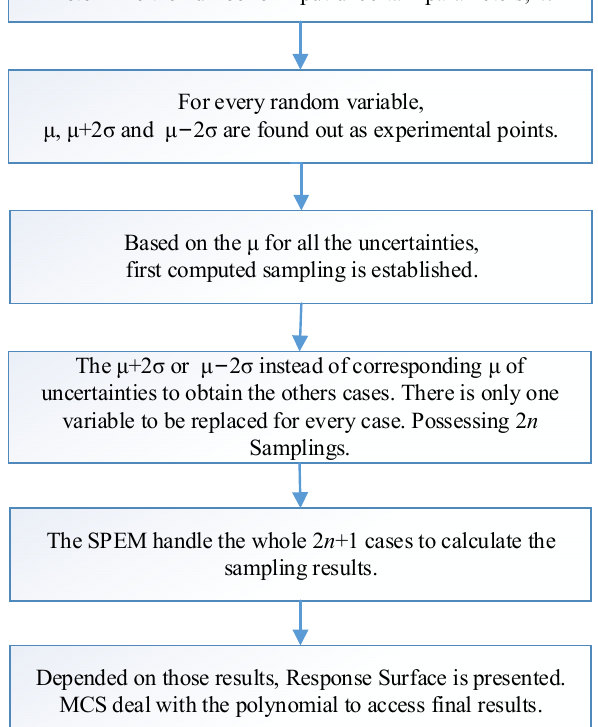
Figure 1. The computational flow diagram of SPEM-RSM.